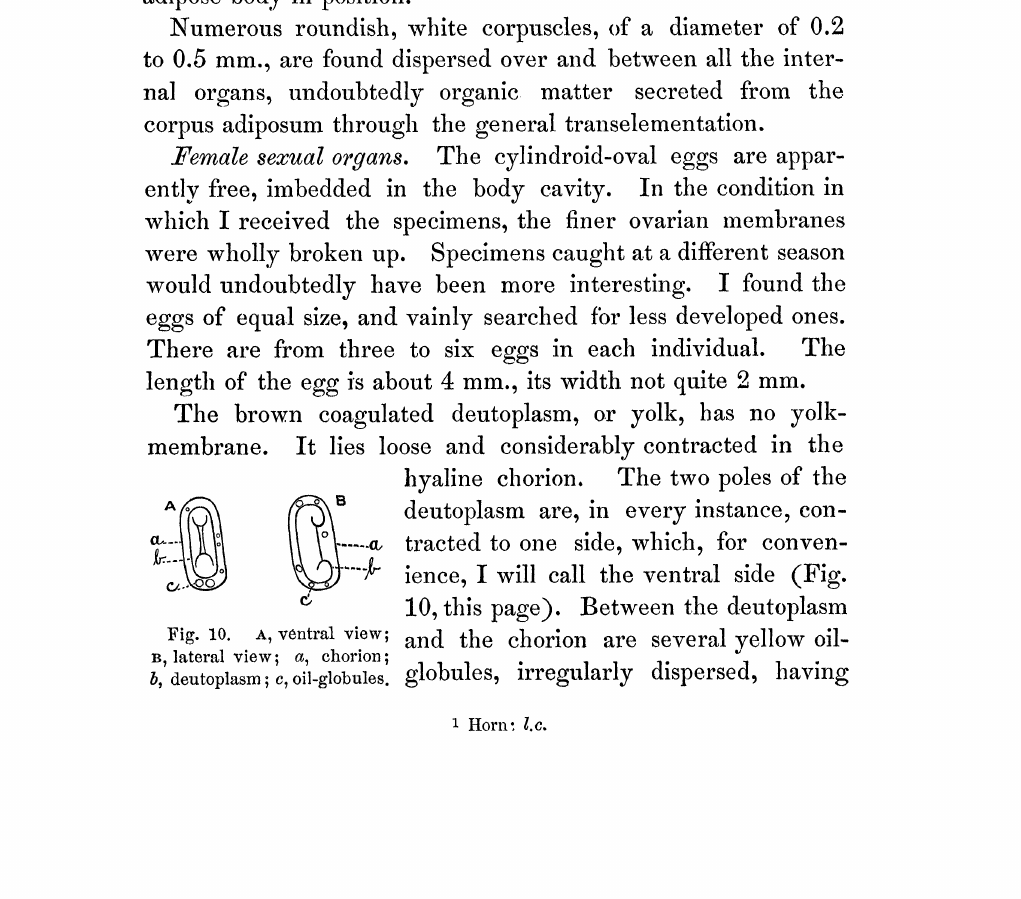
b, deutopasm c, oil-globules,